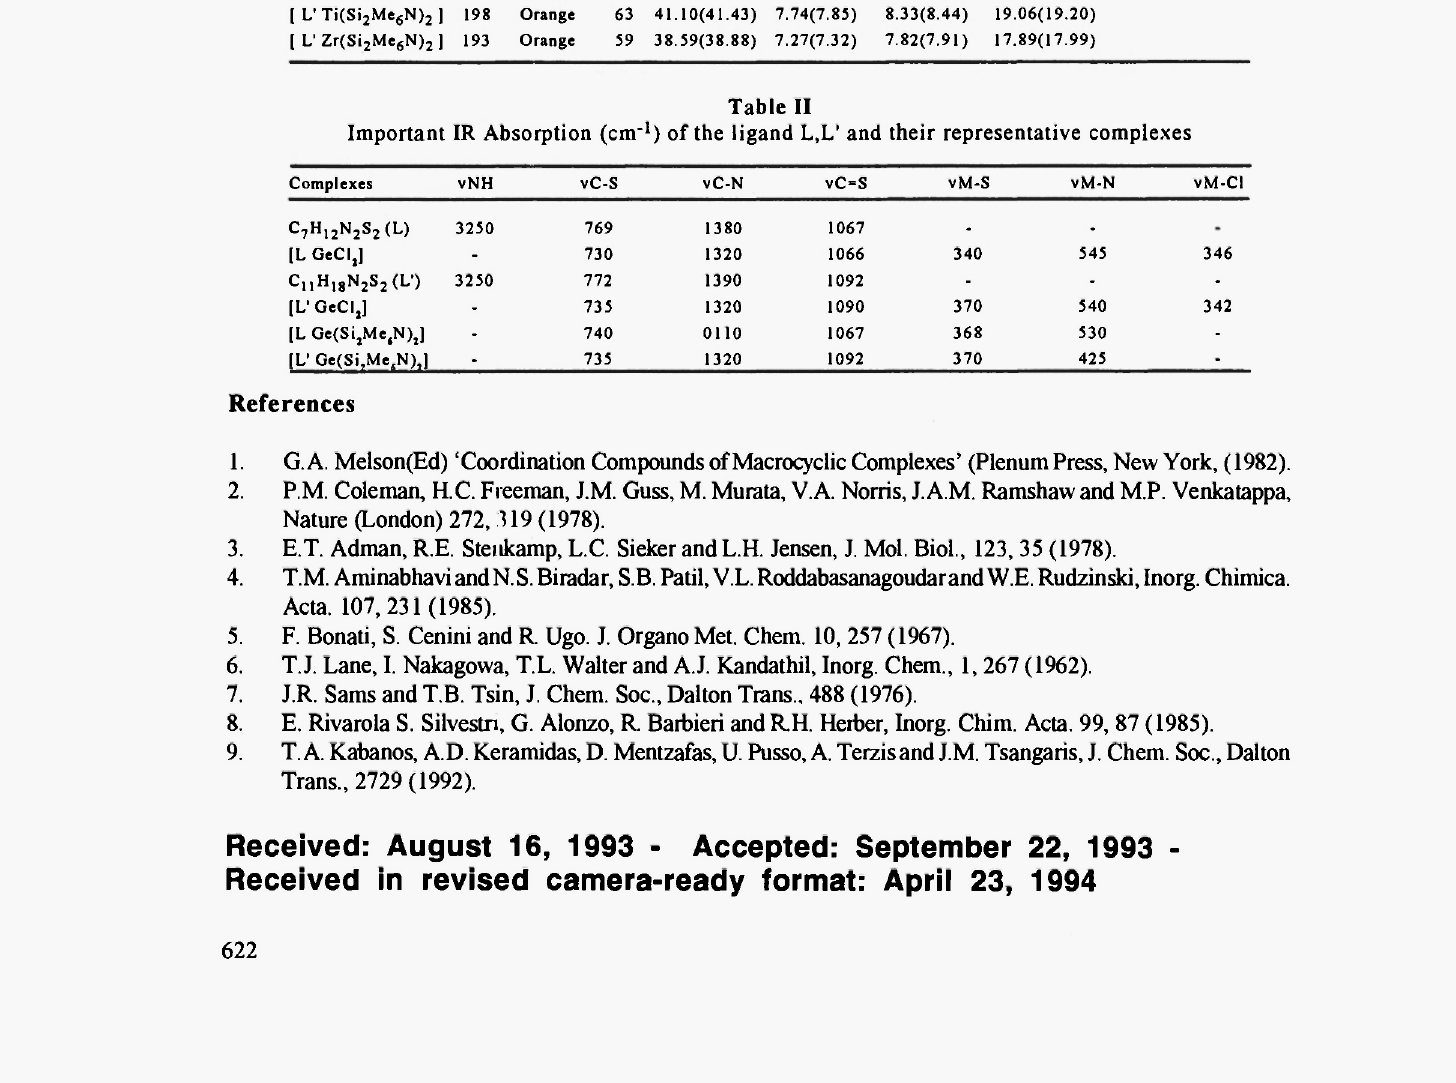
Important IR Absorption (cm" ') of the ligand L.L' and their representative